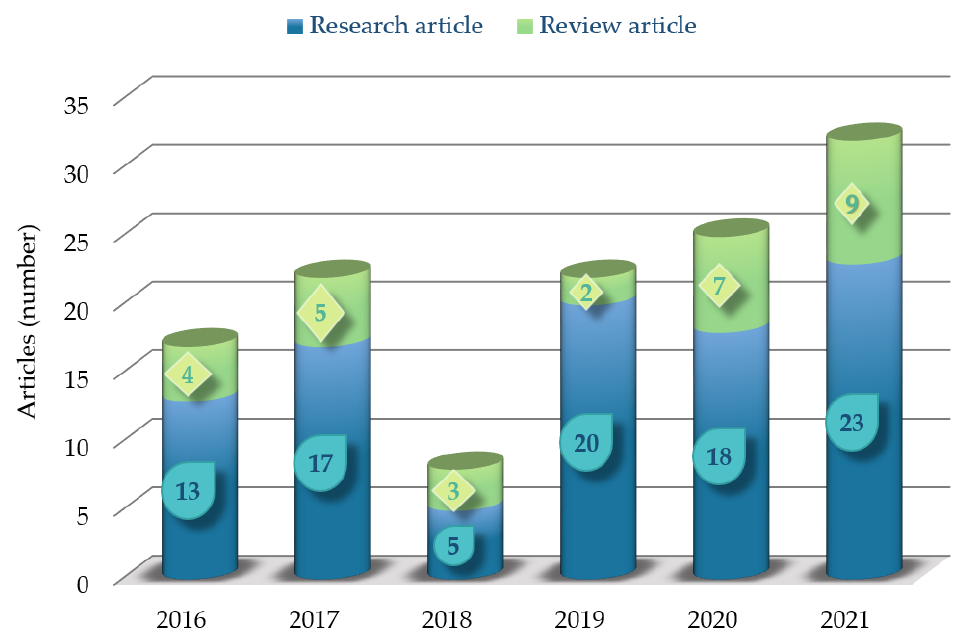
Figure 3. Published papers on the studied topic from January 2016 to July 2021.